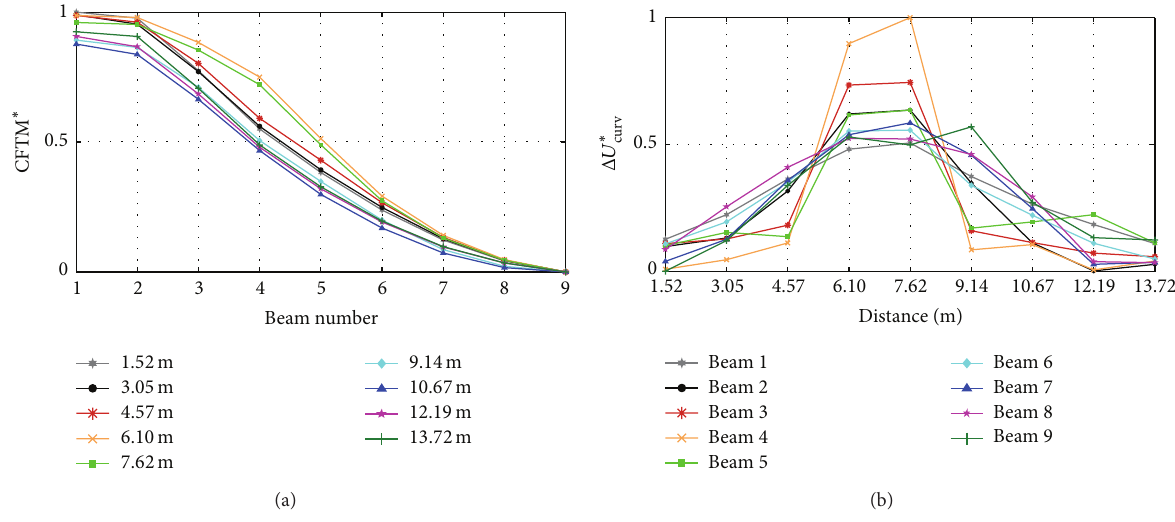
Figure 12: Plot of (a) CFTM ∗ and (b) Δ𝑈 ∗